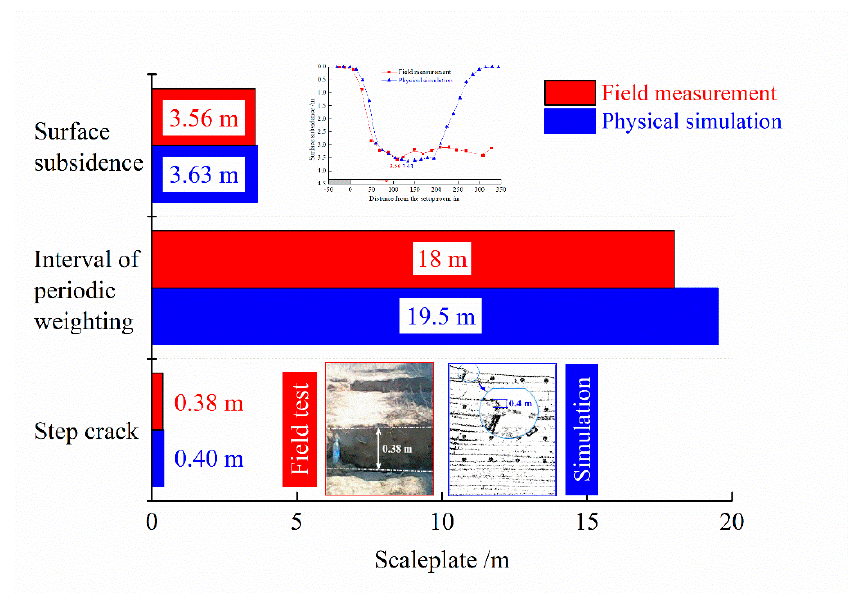
Figure 10. Comparison of physical simulation and field measurement.